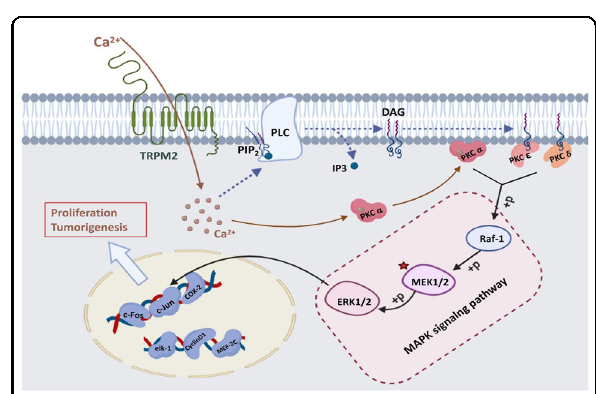
Fig. 8 The graph indicates the mechanisms of how TRPM2 promote pancreatic cancer proliferation and tumorigenesis. The increased level of calcium in pancreatic cancer cell could directly activate PKC α , which in turn cause MAPK pathway activation. On the other hand, the increased calcium level could activate MAPK pathway by indirectly activate PKC ε and PKC δ